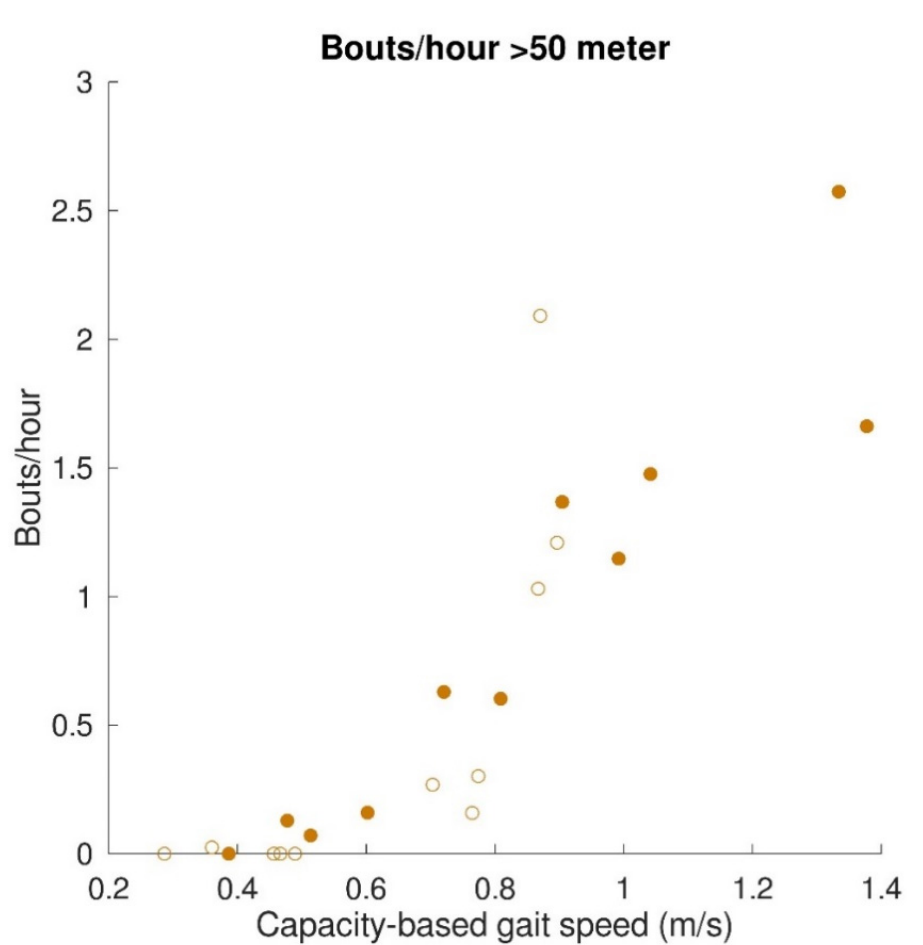
Figure 5. Relation between gait capacity and gait performance (walking activity; distance covered > 50 m). The mean number of bouts/hour with a distance covered > 50 m are represented by filled dots for stroke patients and by open dots for patients with iSCI.